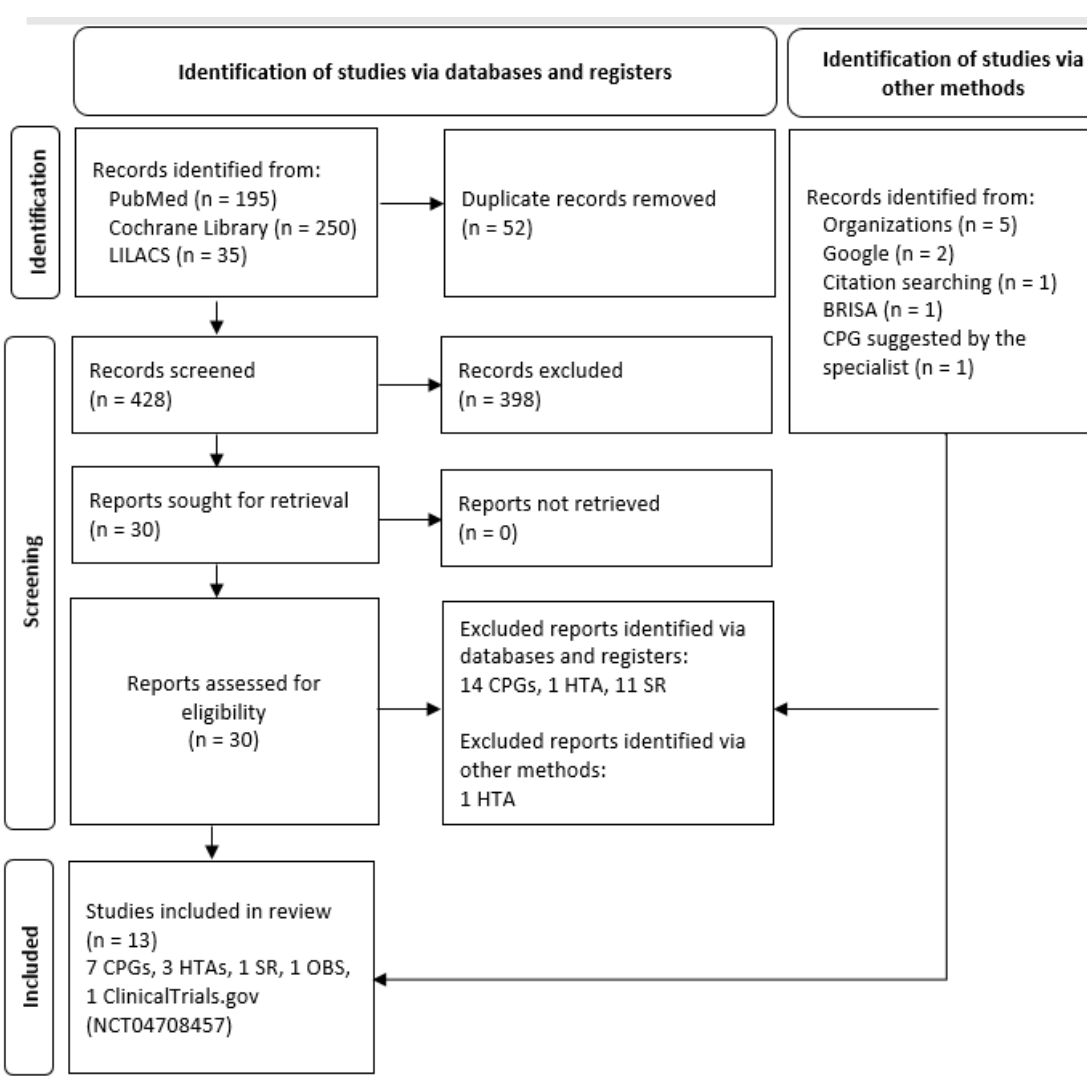
Figure 1. Flowchart of evidence selection. CPG: clinical practice guideline; HTA: health technology assessment; SR: systematic review; OBS: observational study; LILACS: Latin American and Caribbean Health Sciences Literature; BRISA: Regional Database of Health Technology Assessment Reports of the Americas. Flow chart adapted from: Page MJ, et al. The PRISMA 2020 statement: an updated guideline for reporting systematic reviews. BMJ 2021, 372, n71.